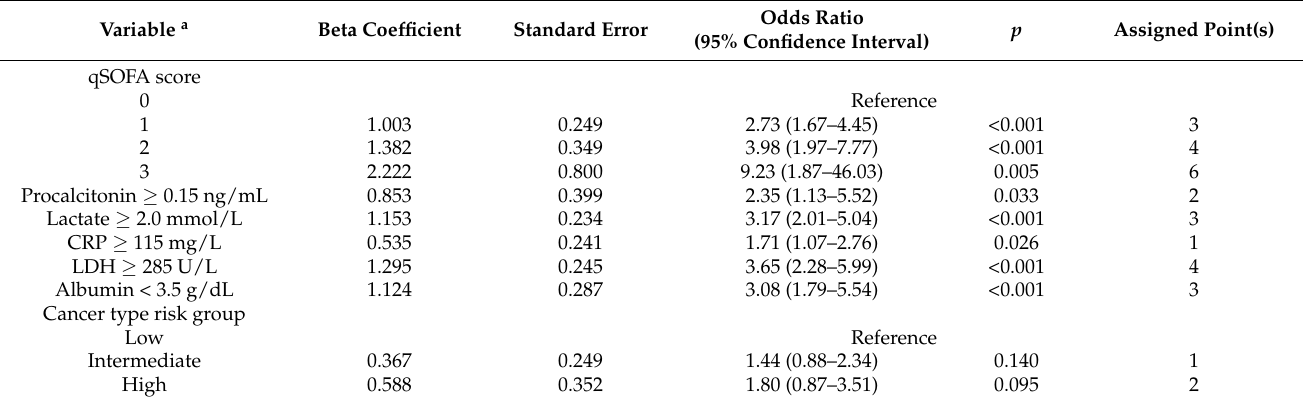
Table 2. Final prediction model used to derive the prediction score for 14-day mortality among cancer patients presenting to the emergency department with suspected infection.